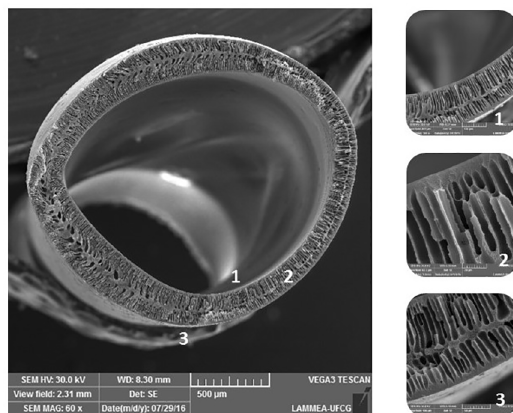
Figure 8 . SEM photomicrographs of the hollow fiber membrane of PES+3%